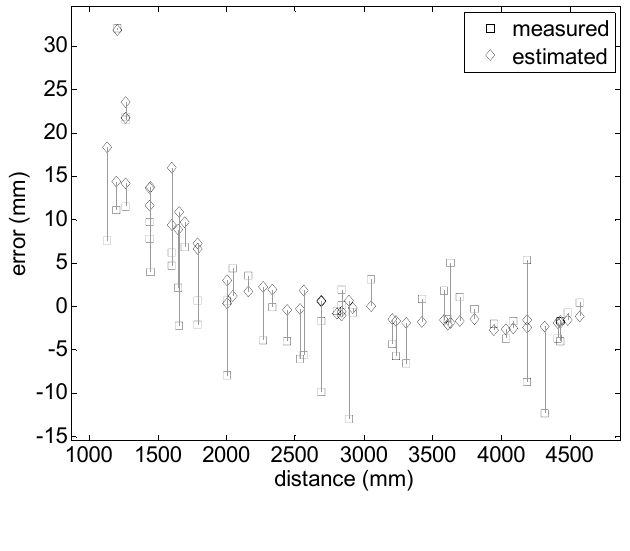
Figure 17. Placement error for different radial target